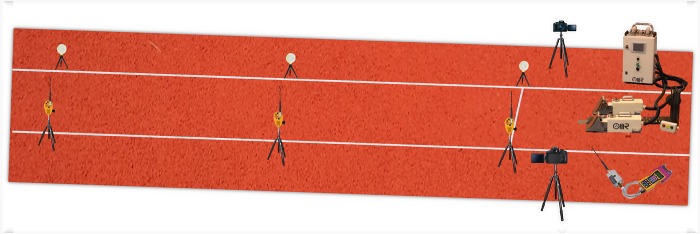
Experimental set-up.